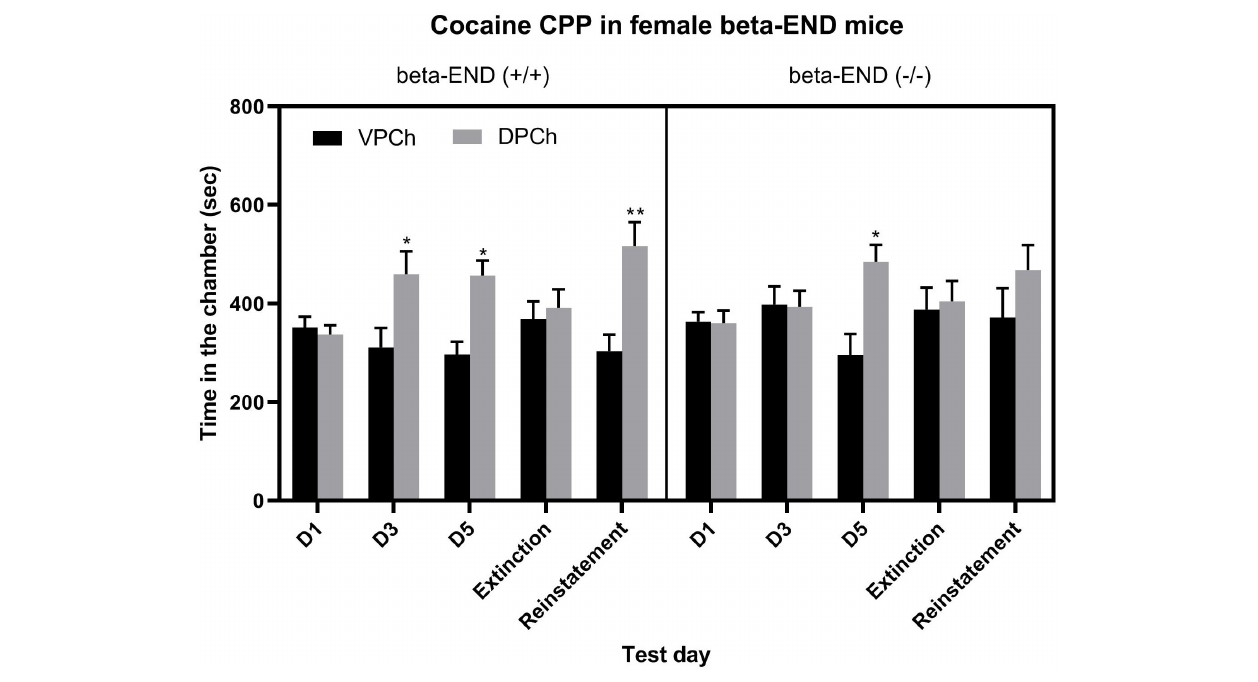
FIGURE 2 | The CPP response was blunted in female mice lacking beta-endorphin compared to their wild-type controls following single but not repeated conditioning with cocaine (15 mg/kg) as well as on the reinstatement test day. Data are mean ( ± SEM) of the amount of time that mice ( n = 8 mice per genotype) spent in the drug-paired chamber (DPCh) versus vehicle-paired chamber (VPCh) on day 1 (D1) and after single (day 3; D3) and repeated (day 5, D5) conditioning with cocaine as well as on the extinction and reinstatement test days; * P < 0.05; ** P < 0.01 vs. their respective VPCh on that